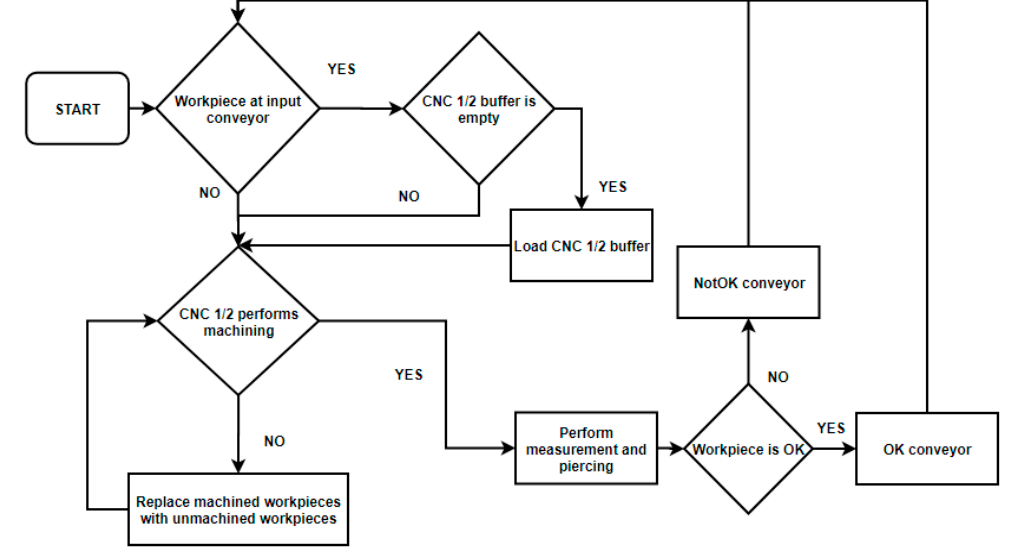
Figure 2. Robot’s decision-making algorithm.